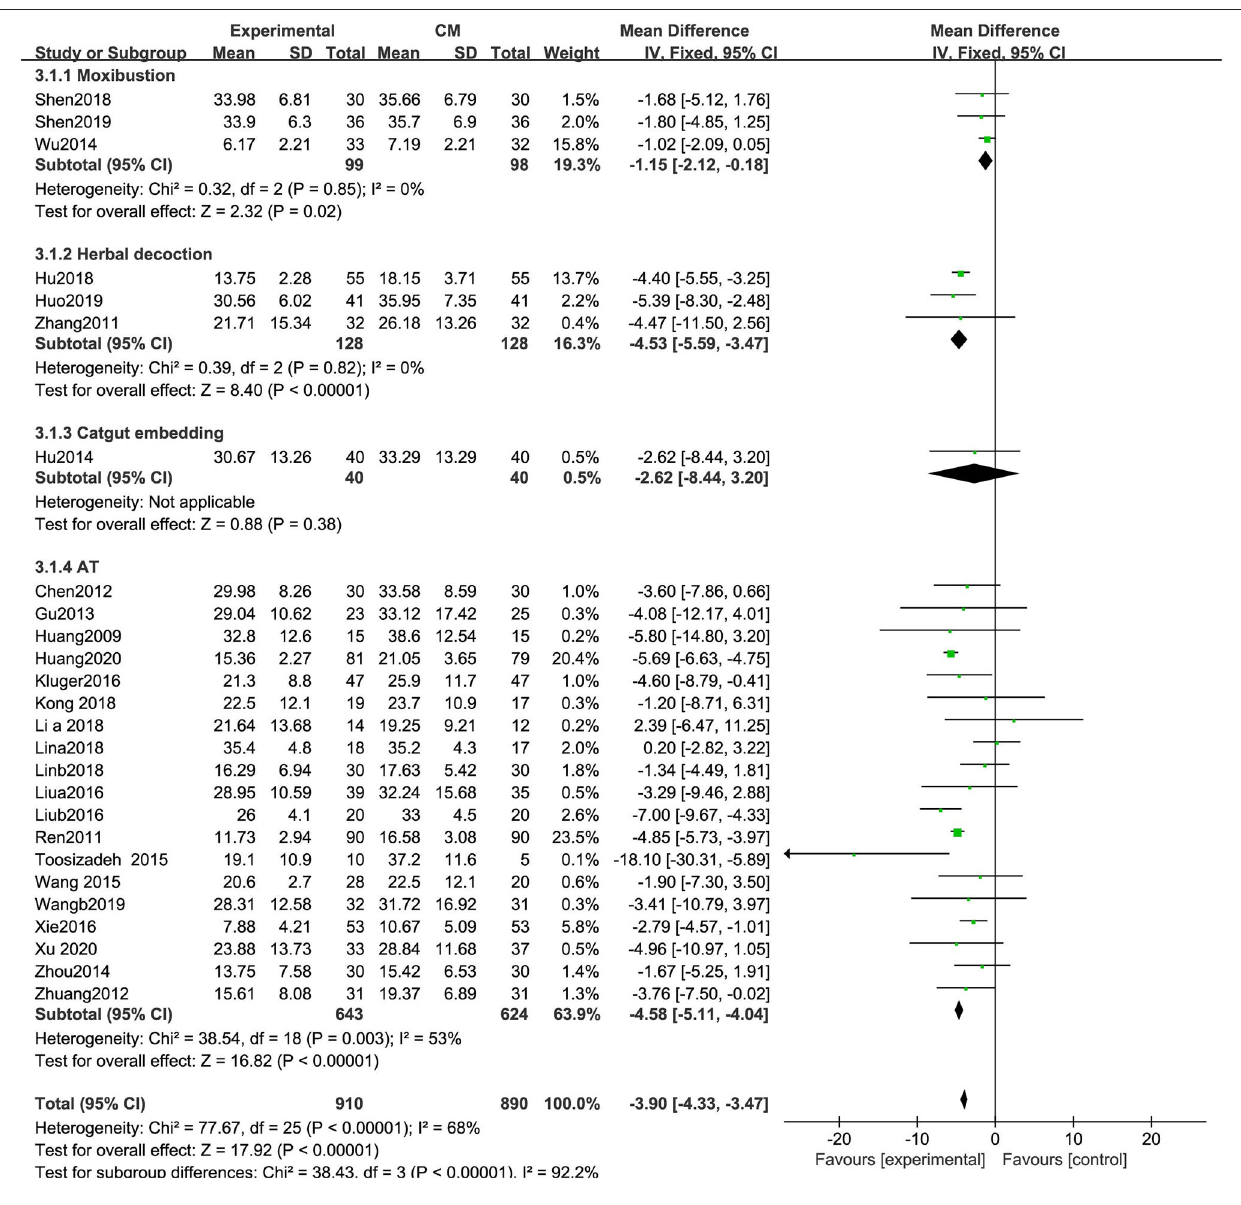
FIGURE 6 | Comparison of acupuncture related therapies in terms of